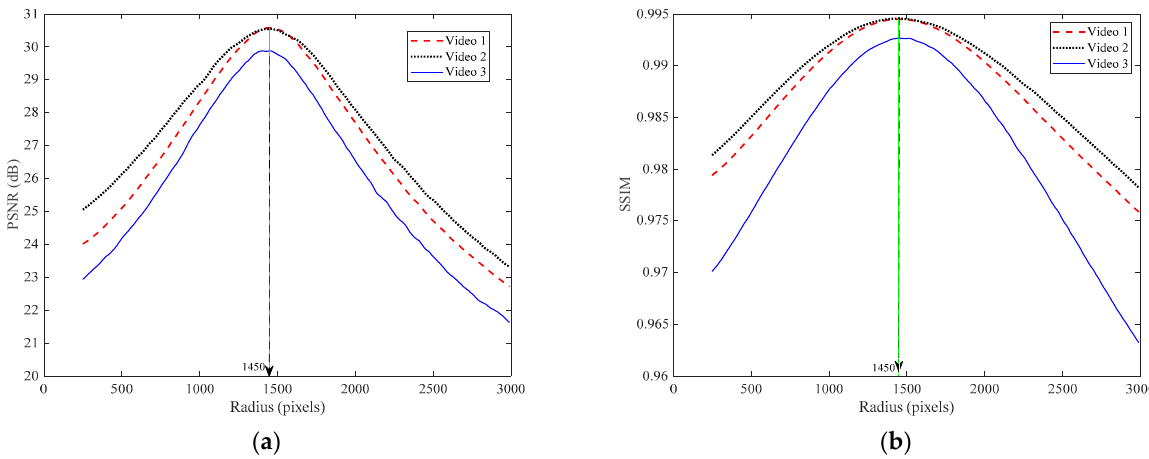
Figure 9. Assessment of video stabilization results with different spherical radii: ( a ) comparison of PSNRs; ( b ) comparison of SSIMs.